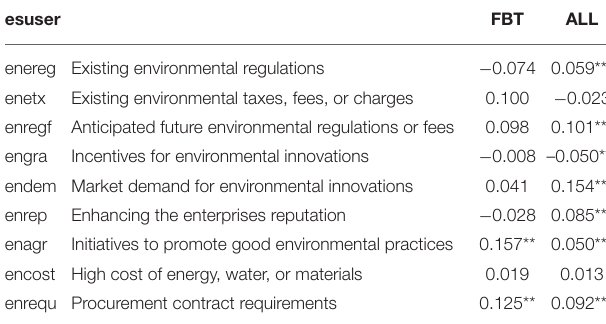
TABLE 9 | Multivariate regression parameters to discover end-users drivers of circular